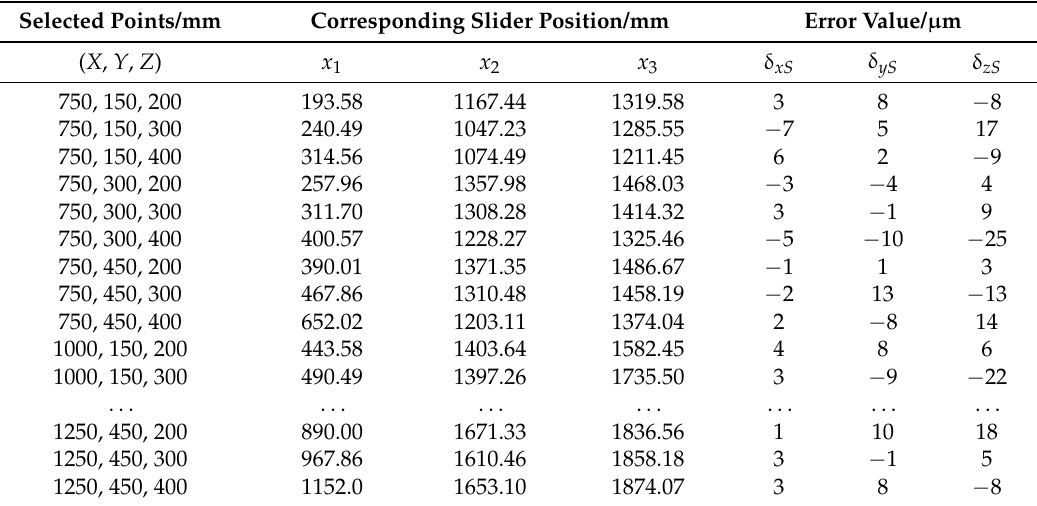
Table 3. Error contributed by straightness motion errors.